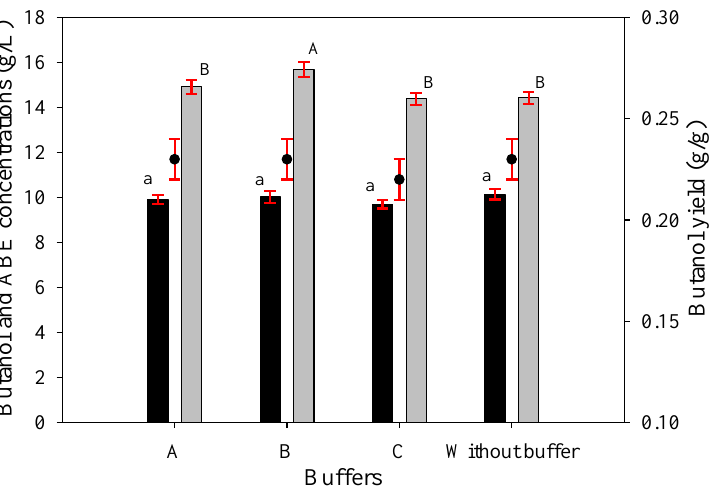
Figure 5. Butanol concentration (black bars), ABE concentration (gray bars), and butanol yield (black dots) values of butanol fermentations from SSJ medium containing 0.64 g/L urea and various buffers with C. beijerinckii TISTR 1461 at 48 h. Buffer A: KH 2 PO 4 , K 2 HPO 4 , and ammonium acetate; buffer B: KH 2 PO 4 and K 2 HPO 4 ; buffer C: ammonium acetate and no buffer. The error bars represent the standard deviation of the mean values. Bars associated with the same letter have no significant differences assessed by Duncan's multiple range test with a critical value of 0.05.